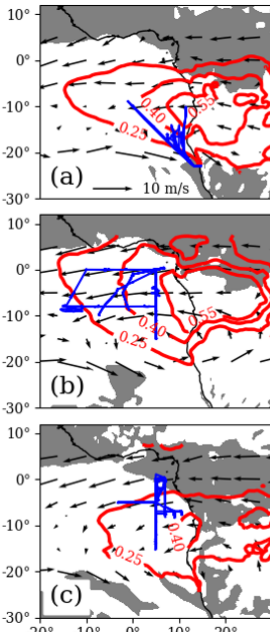
Figure 1. ORACLES P-3 Orion flight tracks (blue) for the (a) September 2016, (b) August 2017, and (c) October 2018 sam- pling periods. Modern-Era Retrospective analysis for Research and Applications (MERRA) monthly mean aerosol optical depth (red contours) and 500hPa winds (arrows) between latitudes 25 ◦ S and 8 ◦ N are shown. Shading indicates where the MERRA monthly mean 500hPa vertical velocity is upwards, shown to emphasize that sampling took place in a region of large-scale subsidence. The boundary between shaded and non-shaded regions indicates a mean velocity of